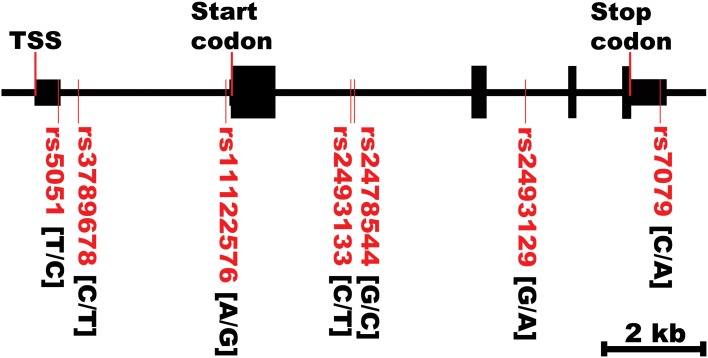
AGT gene structure and SNPs locations. TSS, transcriptional start site. The first bases in the brackets are the common alleles.